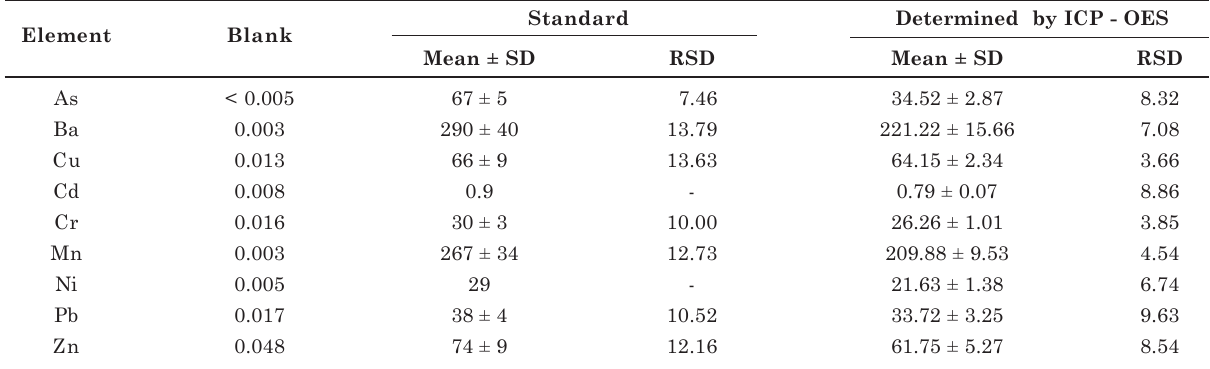
interval.SD: standard deviation; RSD: relative standard Table 3. Mean regional reference values (RRV) obtained from the five legal reserves Metal